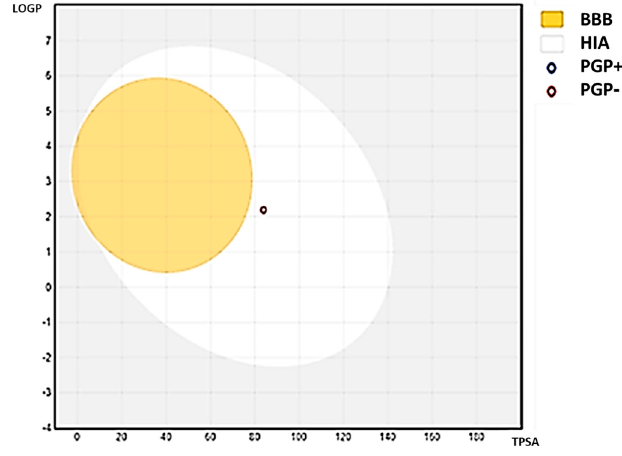
Figure 4. Physcion’s BOILED-Egg plot. The yellow zone (yolk) is for very possible BBB permeability, whereas the white region (GI) is for highly probable HIA (GI) absorption. Molecules with limited absorption and no brain penetration are shown by the outside gray area. The points are also colored blue if the P-gp substrate (PGP+) is anticipated and red if the P-GP non-substrate (PGP) is projected. Table 14. In silico toxicity prediction of C1.